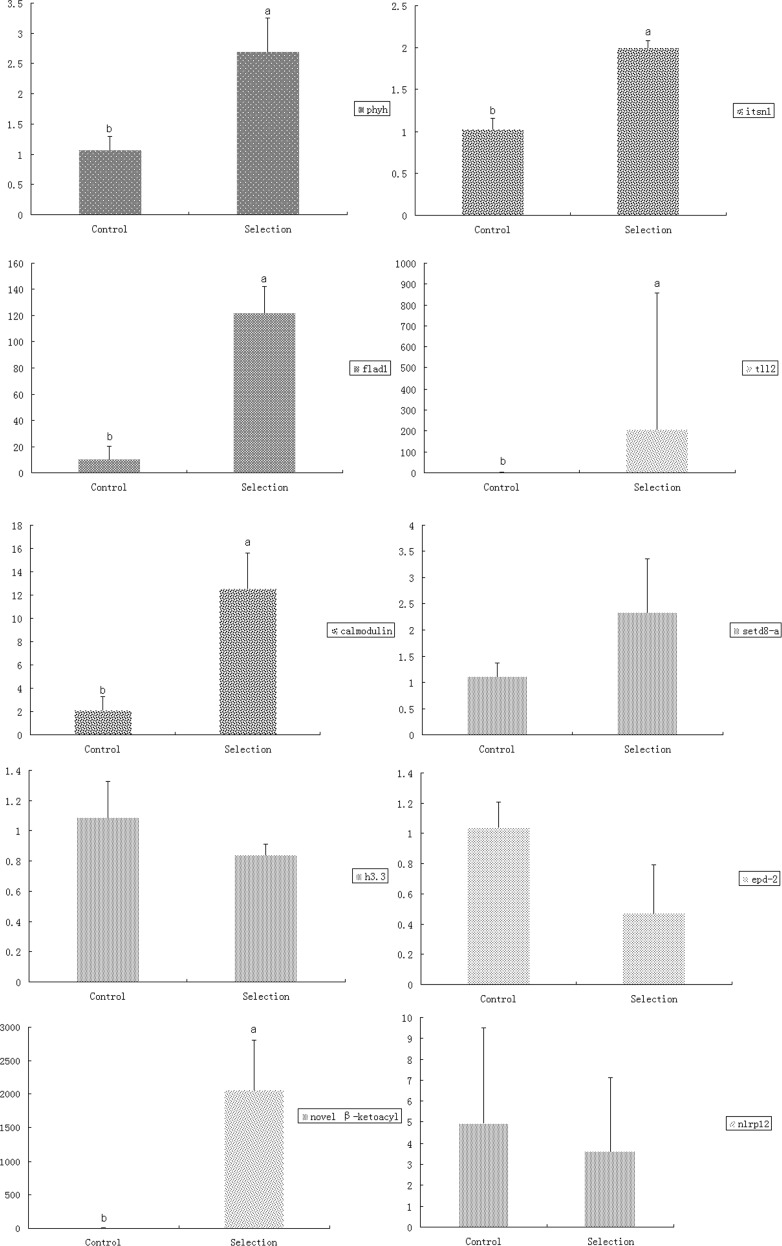
qPCR analysis of a subset of ten differentially expressed genes.Data were normalized to gapdh as the reference gene and presented as a fold change between the Selected and Control groups (mean±SD). Results were analyzed by the t-test, where different letters indicate significant (P < 0.05) differences.